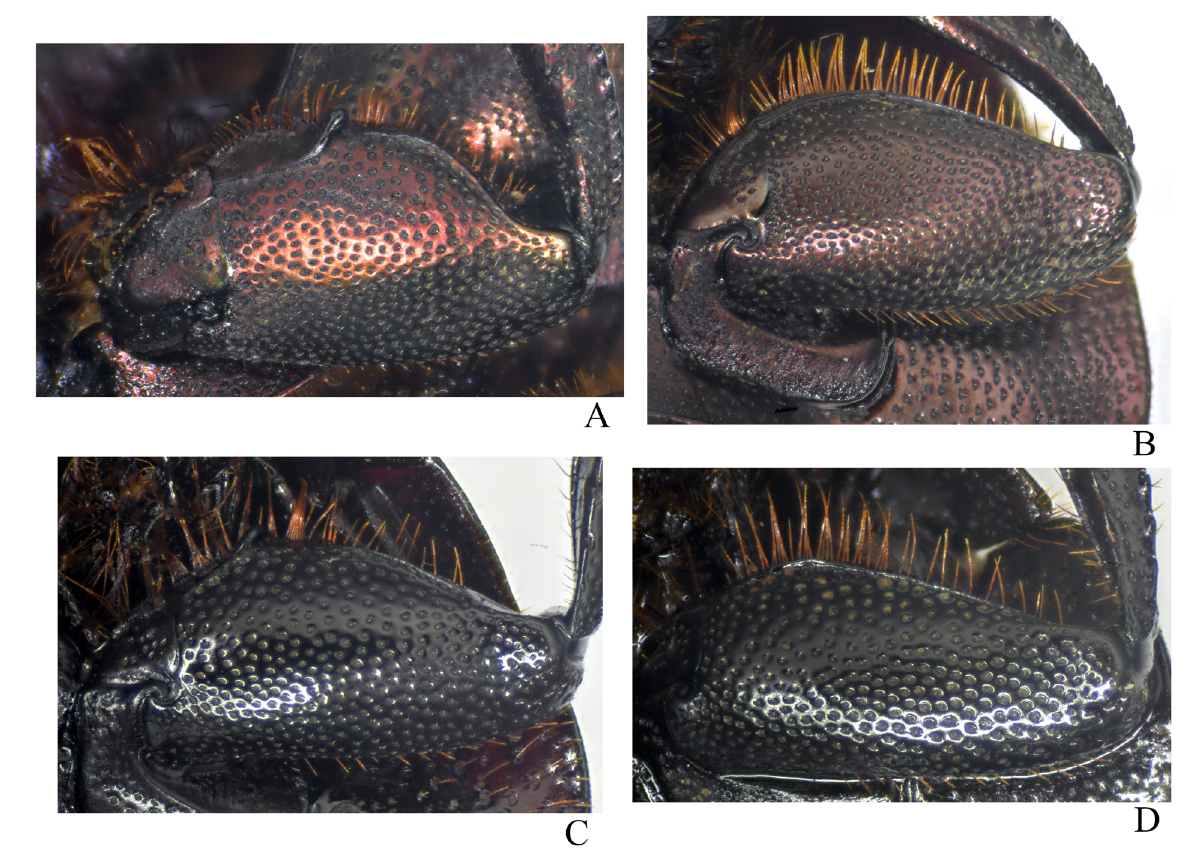
Fig. 14. Profemora. A‒B . Streblopus opatroides van Lansberge, 1874. A . ♂. B . ♀. C‒D . S. punctatus (Balthasar, 1938). C . ♂. D . ♀. Note the differences between the species and sexes in relation to the overall shape of the profemora and the presence of spurs on the anterior edge in